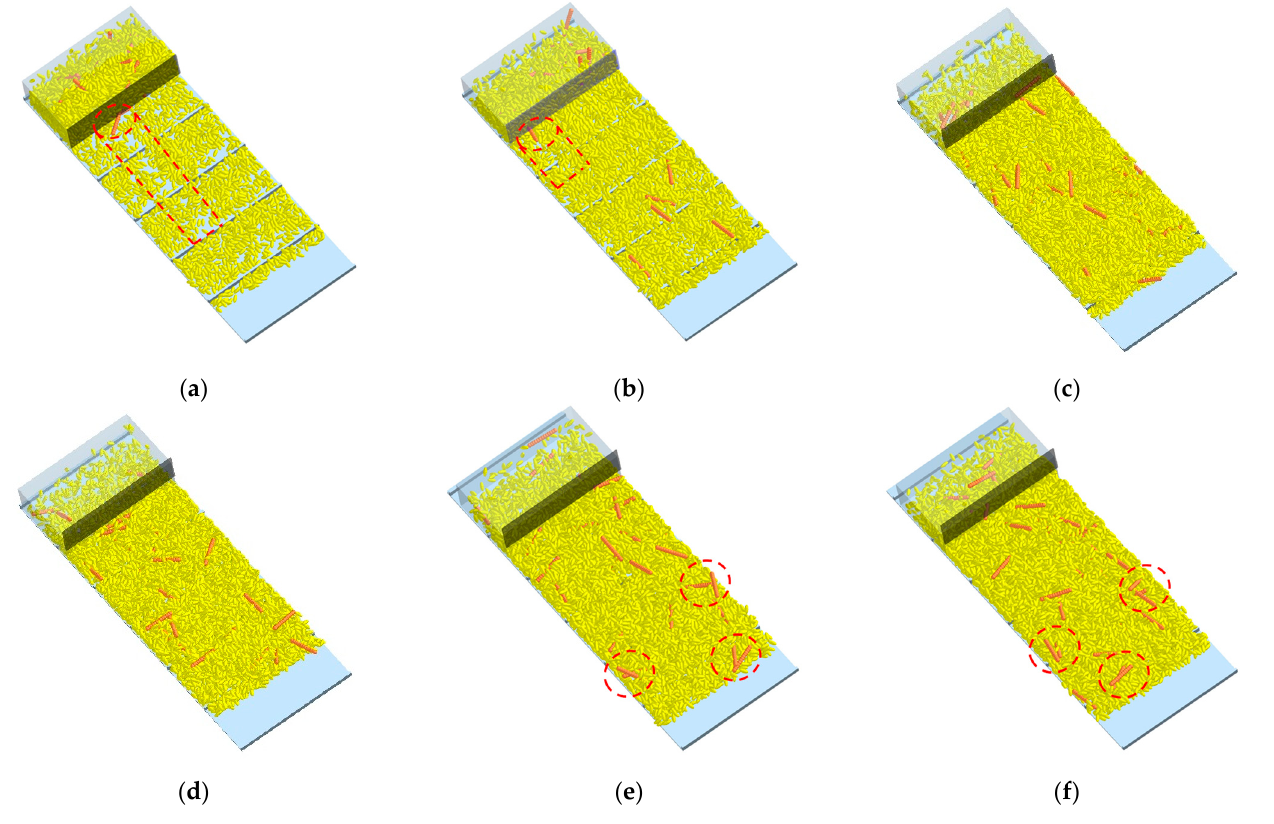
Figure 12. Grain distribution analysis under different deflector gap. ( a ) d = 7.5 mm; ( b ) d = 10 mm; ( c ) d = 12.5 mm; ( d ) d = 15 mm; ( e ) d = 17.5 mm; ( f ) d = 20 mm.